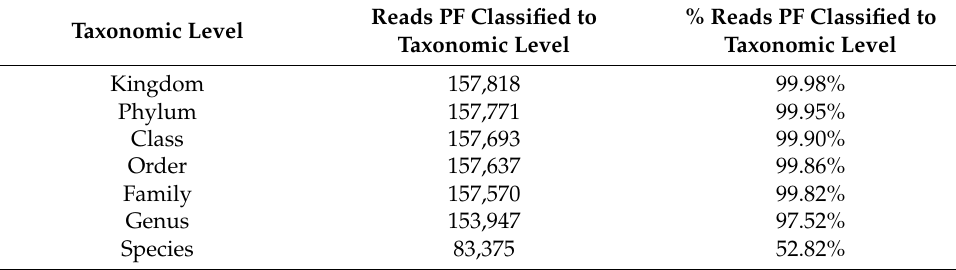
Table 1. Read mapping and classification statistics.